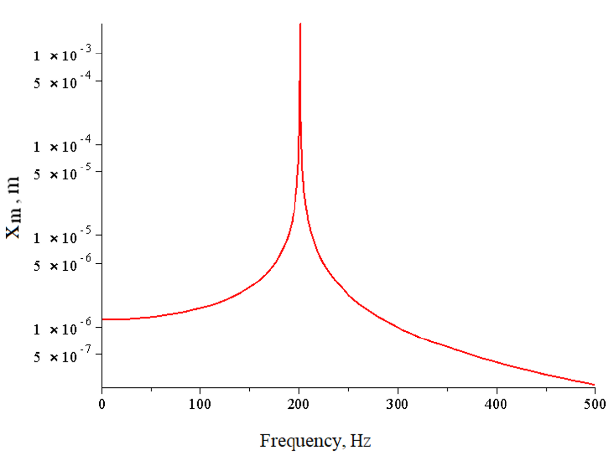
Figure 3. Hydroelastic response of the channel wall. The theoretical curve is based on experimental data [23].